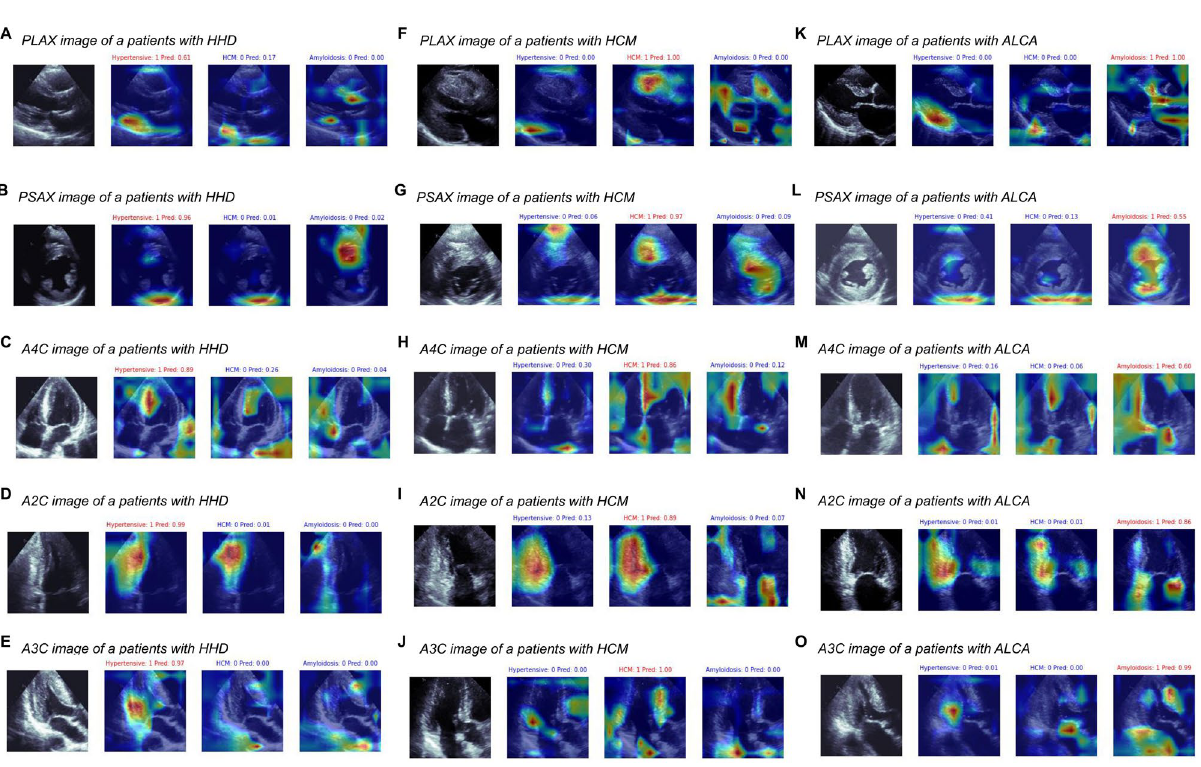
Figure 3. Representative figures in the class activation mapping. Typical class activation maps of patients with HHD ( A–E ), HCM ( F–J ), or ALCA ( K–O ), are presented. AUC area under the ROC curve, CI confidence interval, ALCA light-chain cardiac amyloidosis, HCM hypertrophic cardiomyopathy, HHD hypertensive heart disease, ROC receiver operating characteristic